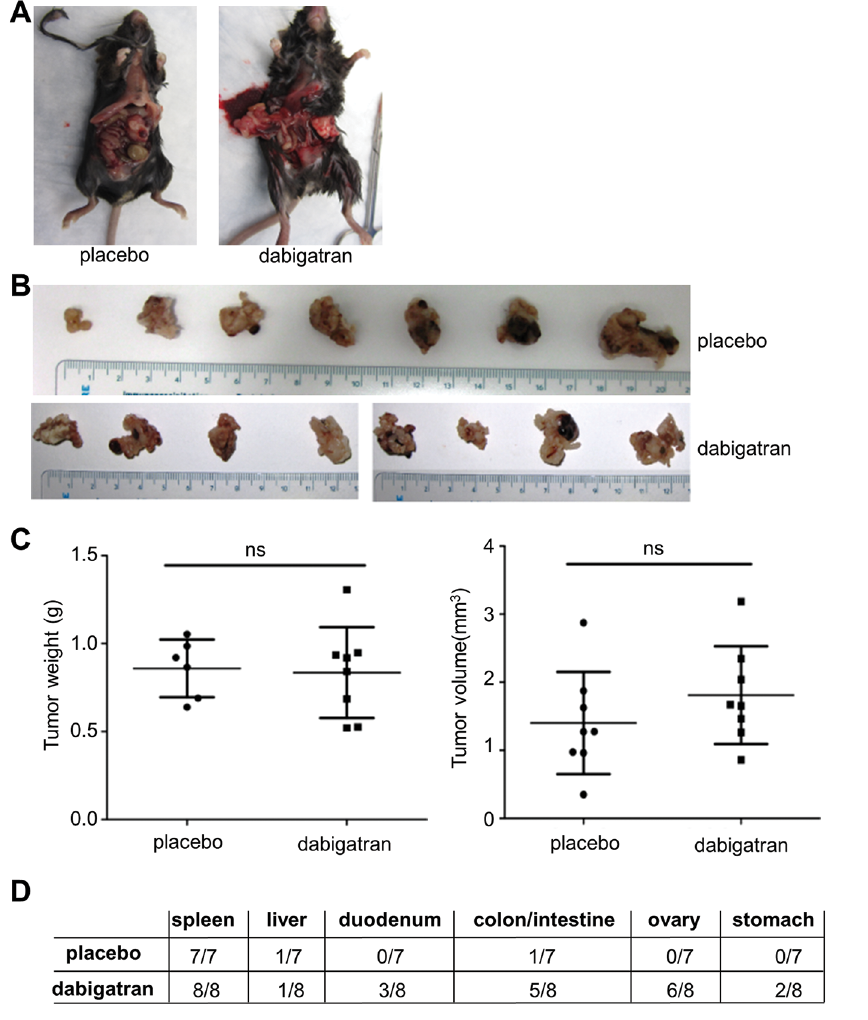
Figure 1. Influence of dabigatran monotherapy on pancreatic cancer growth and tumor cell dissemination. (A) Representative pictures of bleeding in the peritoneal cavity of dabigatran-treated mice at the moment of euthanization. (B) Pancreatic tumors derived 3 wks after tumor cell inoculation from mice after placebo or dabig- atran treatment. (C) Weight and size of the tumors depicted in (A). Indicated is the mean ± standard error of the mean (SEM) (n = 7–8 mice per group). NS = not signifi- cant. (D) Number of mice with distant metastasis in the indicated organs at the time of euthanization (7–8 mice per